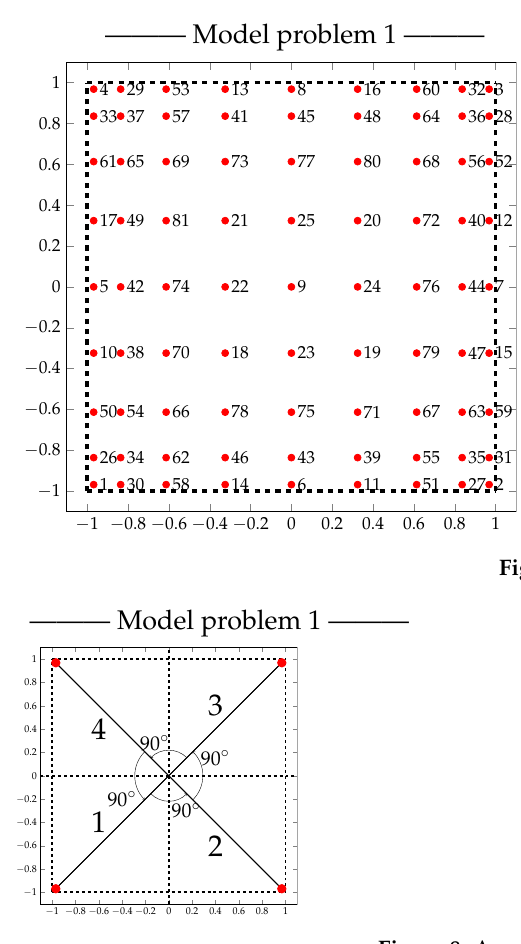
Figure 8. Areas of a unit element and rotation of one point from Area 1 for model problem 1 and